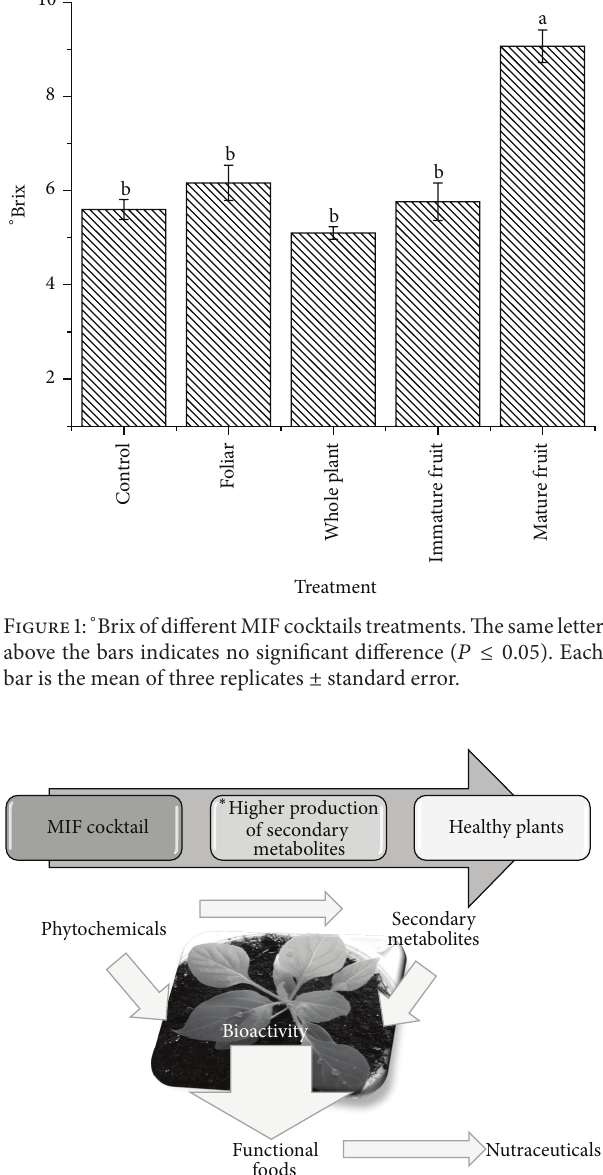
Figure 2: Suggested implications of the application of the MIF